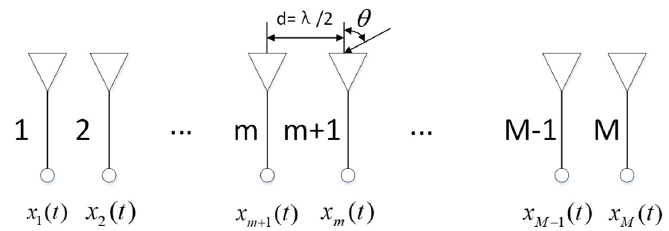
Figure 1. Array element layout.